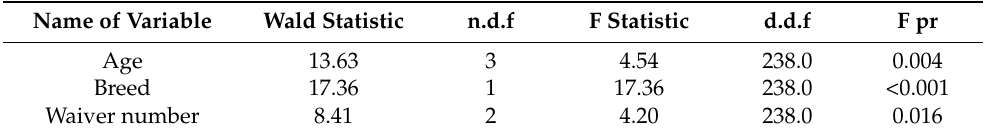
Table 5. REML multivariate model output assessing interactions between predictor values and LOS (final model).